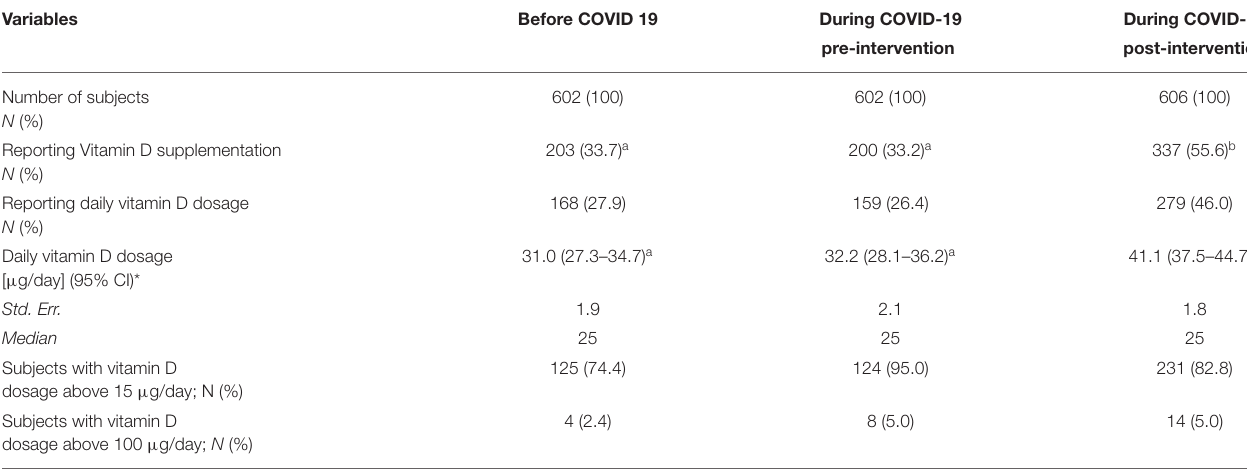
TABLE 5 | Vitamin D supplementation practices before and during the COVID-19 pandemic. Variables